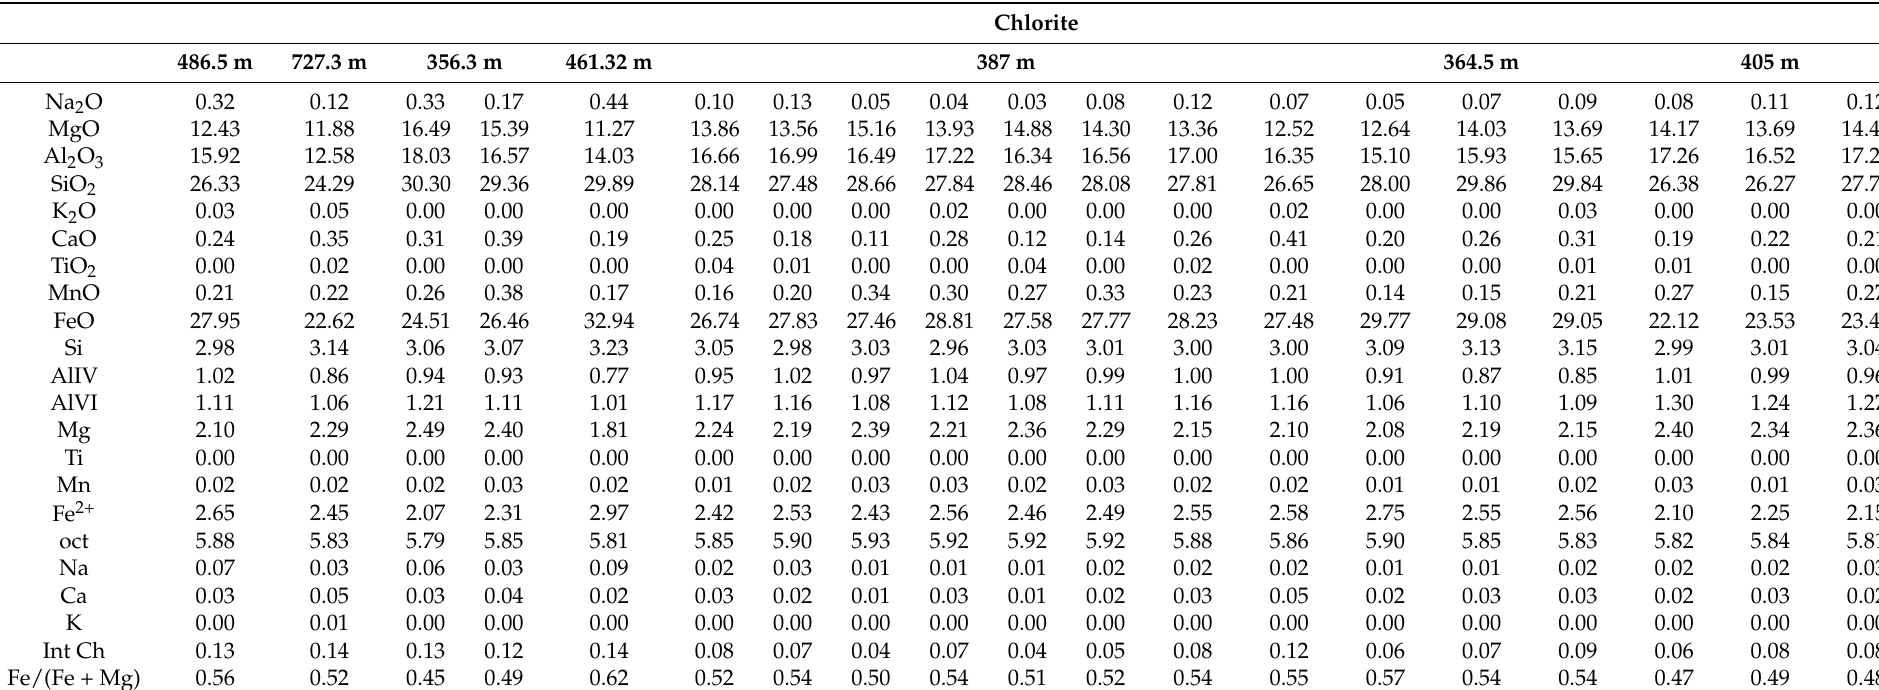
Table 1. Representative chemical compositions of chlorite. Structural formulas are calculated (per14 oxygens). Analyses obtained by EDS on polished thin